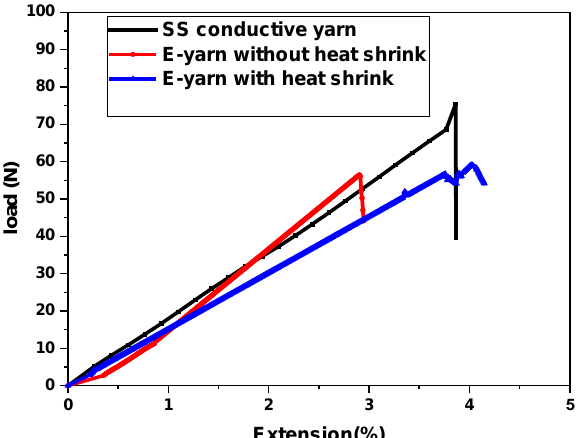
Figure 10. Strength of stainless steel conductive yarn and SMD LED-embedded E-yarns.